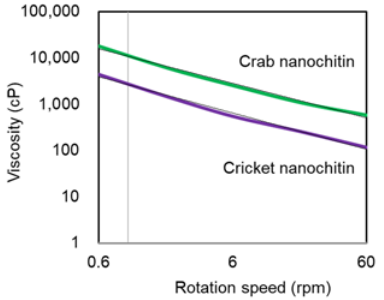
Figure 9. The viscosity of nanochitin dispersion from cricket and crab shell.